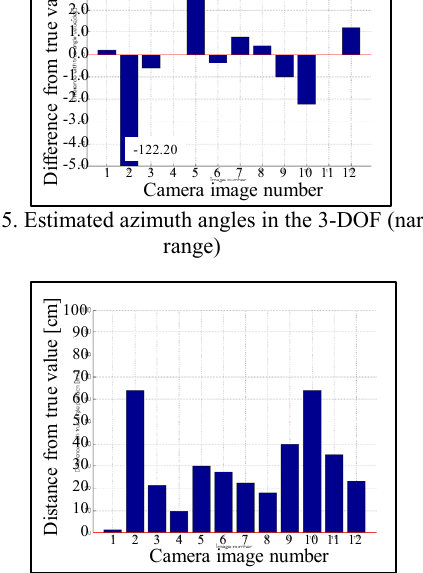
Figure 16. Estimated camera positions in the 3-DOF